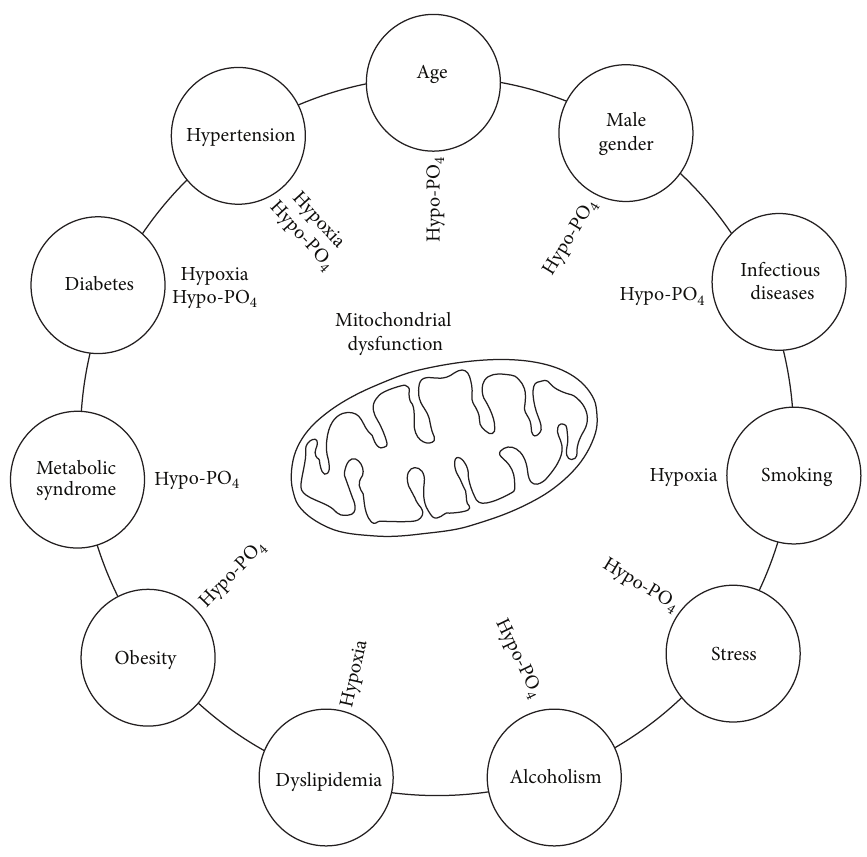
Figure 1: The present concept indicates that the risk factors for cardiovascular disease lead to mitochondrial dysfunction due to either hypophosphatemia and/or hypoxia (see text).